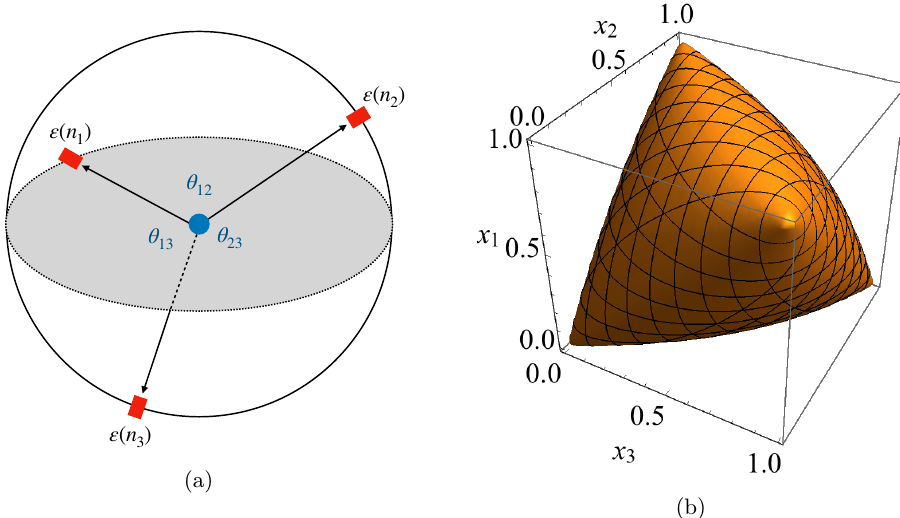
Figure 1 . (a) A graph on the three-point energy correlator. The three detectors are separated by finite angles θ , θ and θ , capturing outgoing particles at specific angles from the hard 12 13 23 interaction and summing their energies. (b) The “zongzi”-shaped kinematic space { x is constrained by the four-particle phase